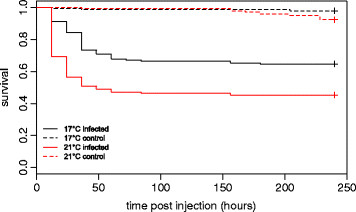
Survival plot of sticklebacks from different temperature treatments after infection with
Vibrio sp.
or PBS medium. Lines show means for all populations pooled.